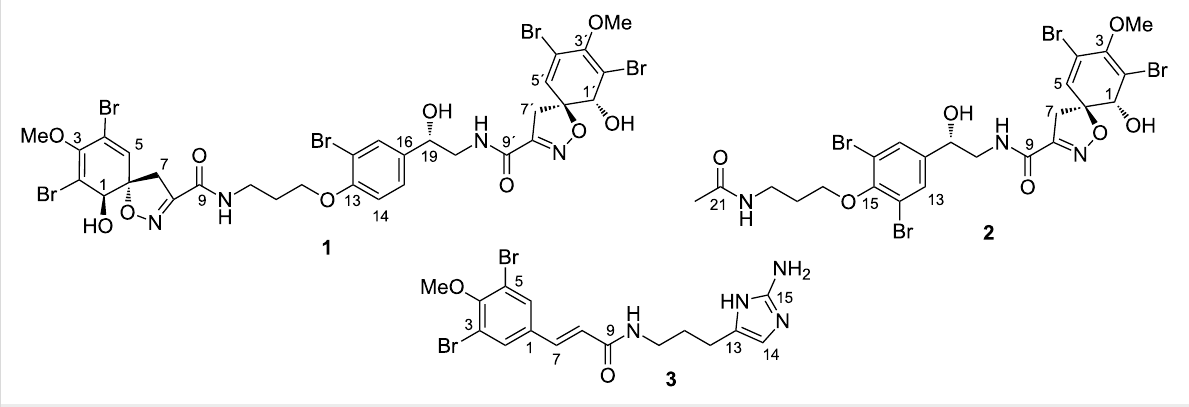
Figure 1: Three new bromotyrosine derivatives isolated from sponge Aplysina lacunosa : 14-debromo-11-deoxyfistularin-3 ( 1 ), aplysinin A ( 2 ), and aplysinin B ( 3 ).